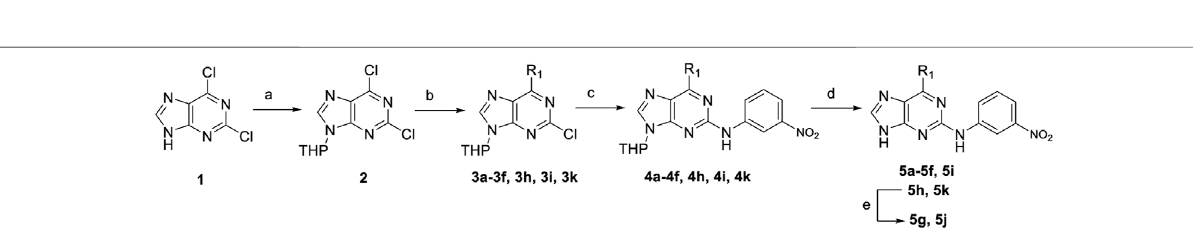
SCHEME1| Synthetic routeoftargetcompounds 5a - 5k .Reagents andconditions: (A) 3,4-dihydro-2 H -pyran, DL -Camphorsulfonicacid,EA,65 ° C,18 h; (B) aryl borate ester,